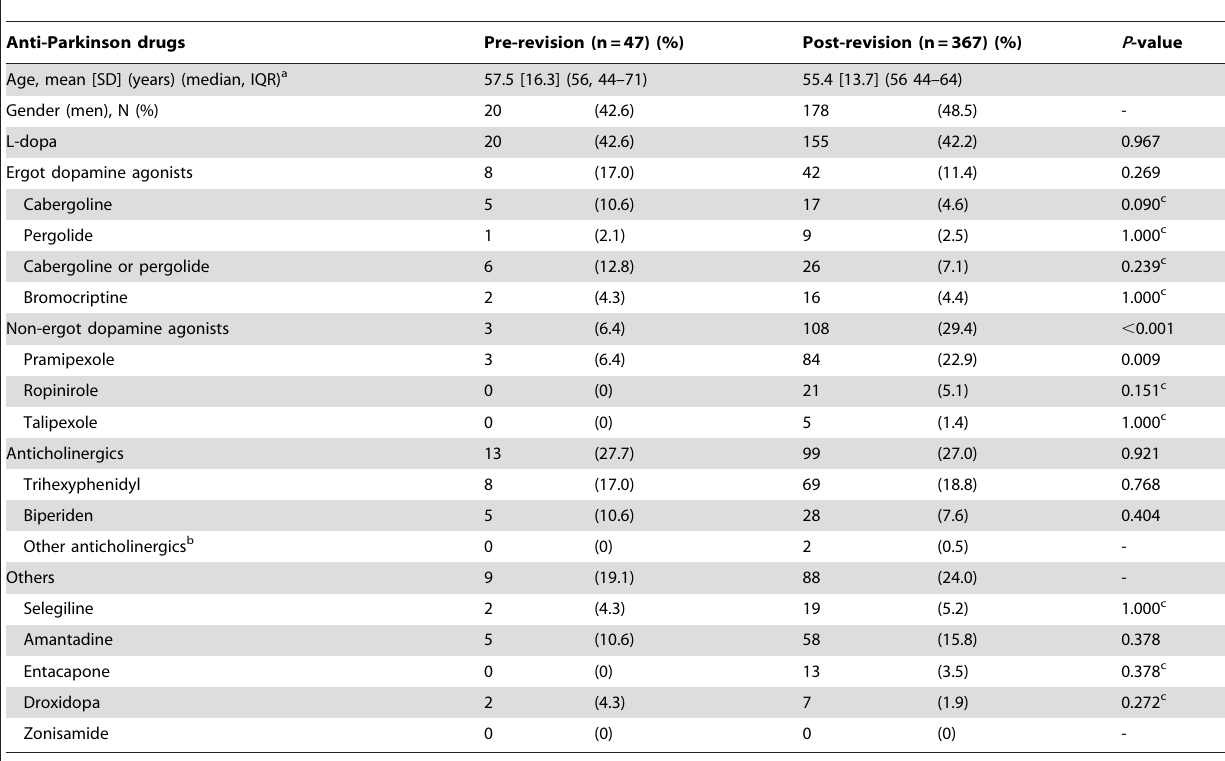
Table 2. Proportions of First-line Drugs Prescribed Before and After Cabergoline and Pergolide Product Label Revisions for Valvulopathy Risk.